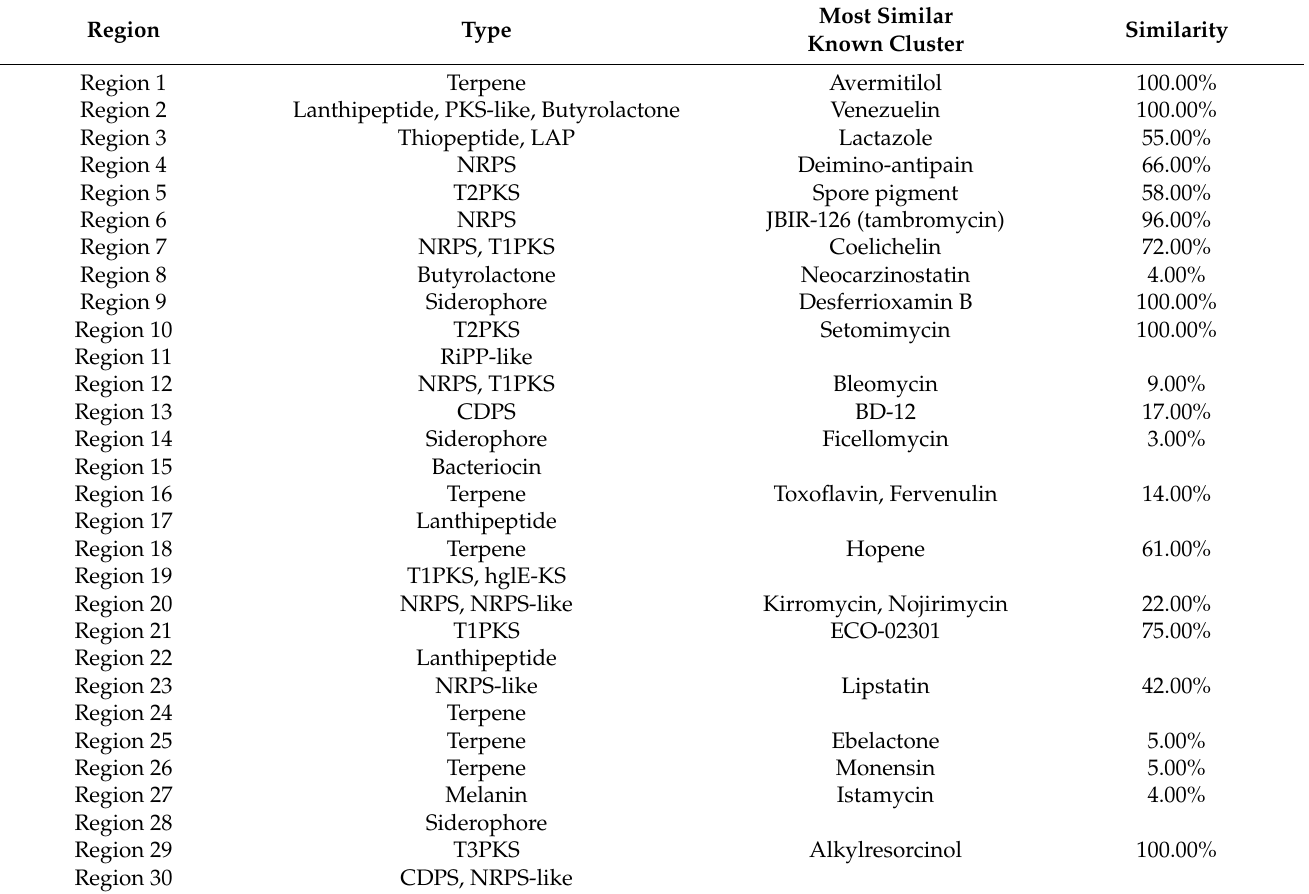
Table 2. Predicted biosynthetic gene clusters of S. nojiriensis JCM